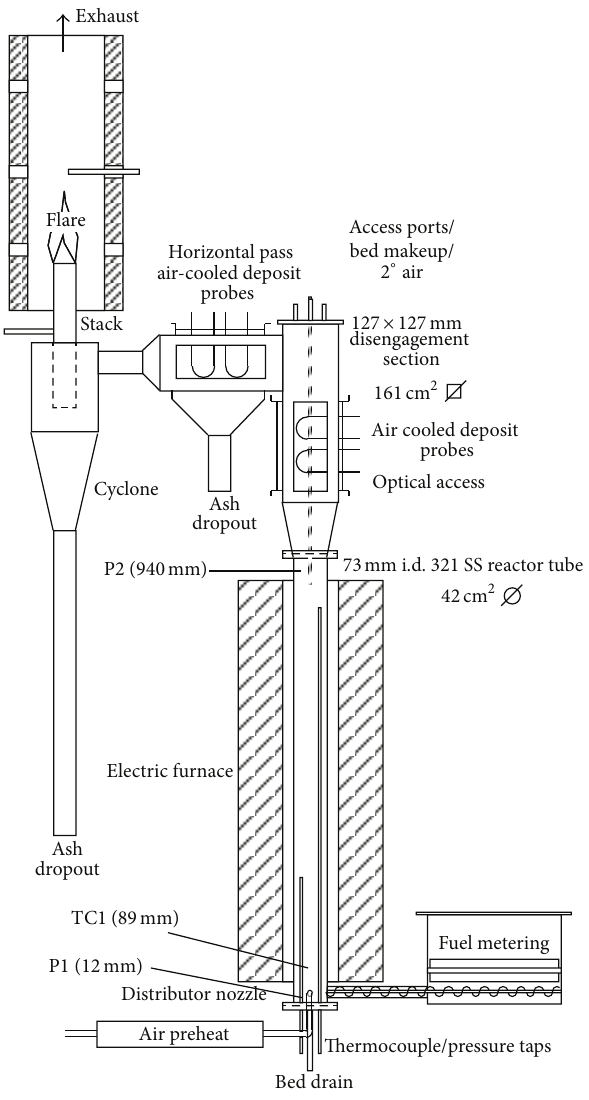
Figure 1: Fluidized-bed reactor (TC = thermocouple, P = pressure tap, and D = disengagement